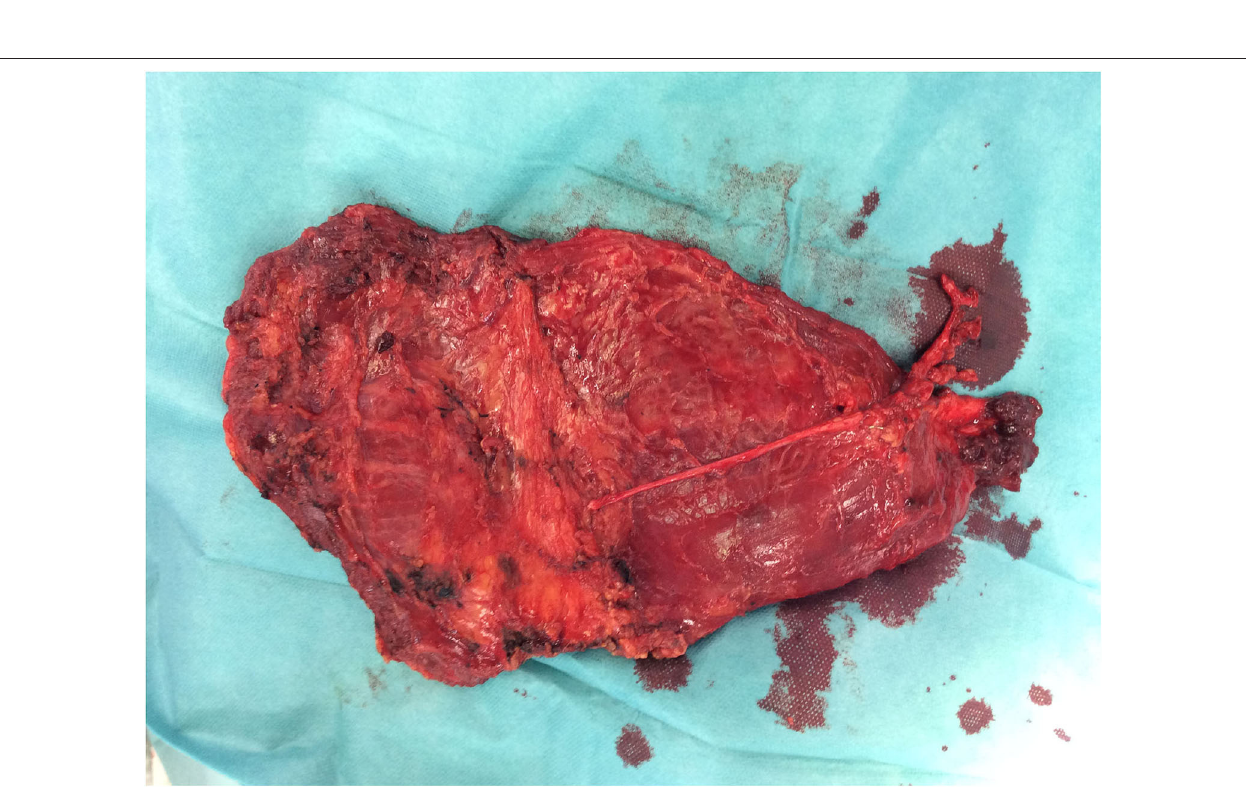
Frontiers in Surgery |